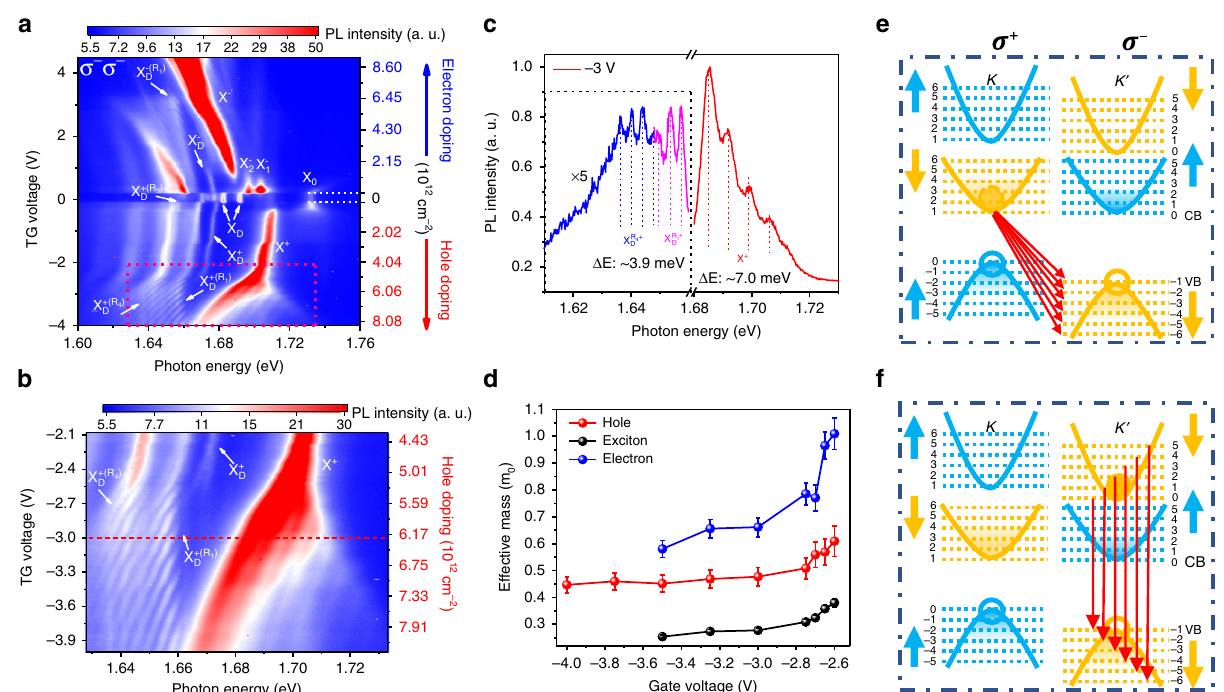
; X (cid:1)ð R 1 Þ , D D